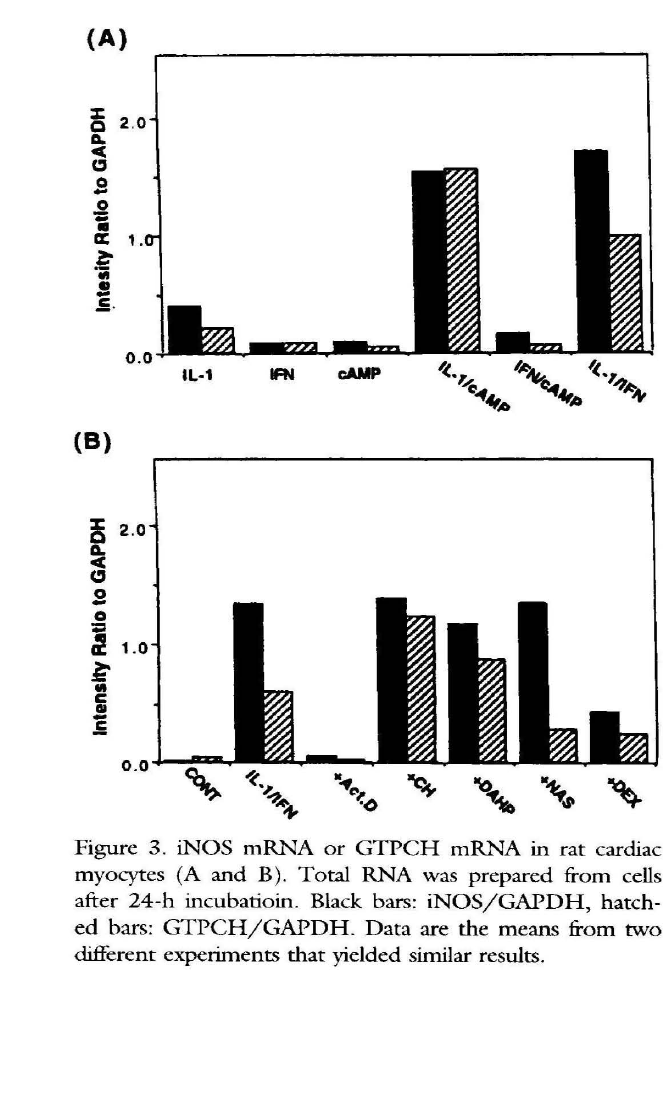
Figure 3. iNOS mRNA or GTPCH mRNA in rat cardiac myocytes (A and B). Total RNA was prepared from cells after 24-h incubatioin. Black bars: iNOSjGAPDH, hatch ed bars: GTPCHjGAPDH. Data are the means from two different experiments that yielded similar